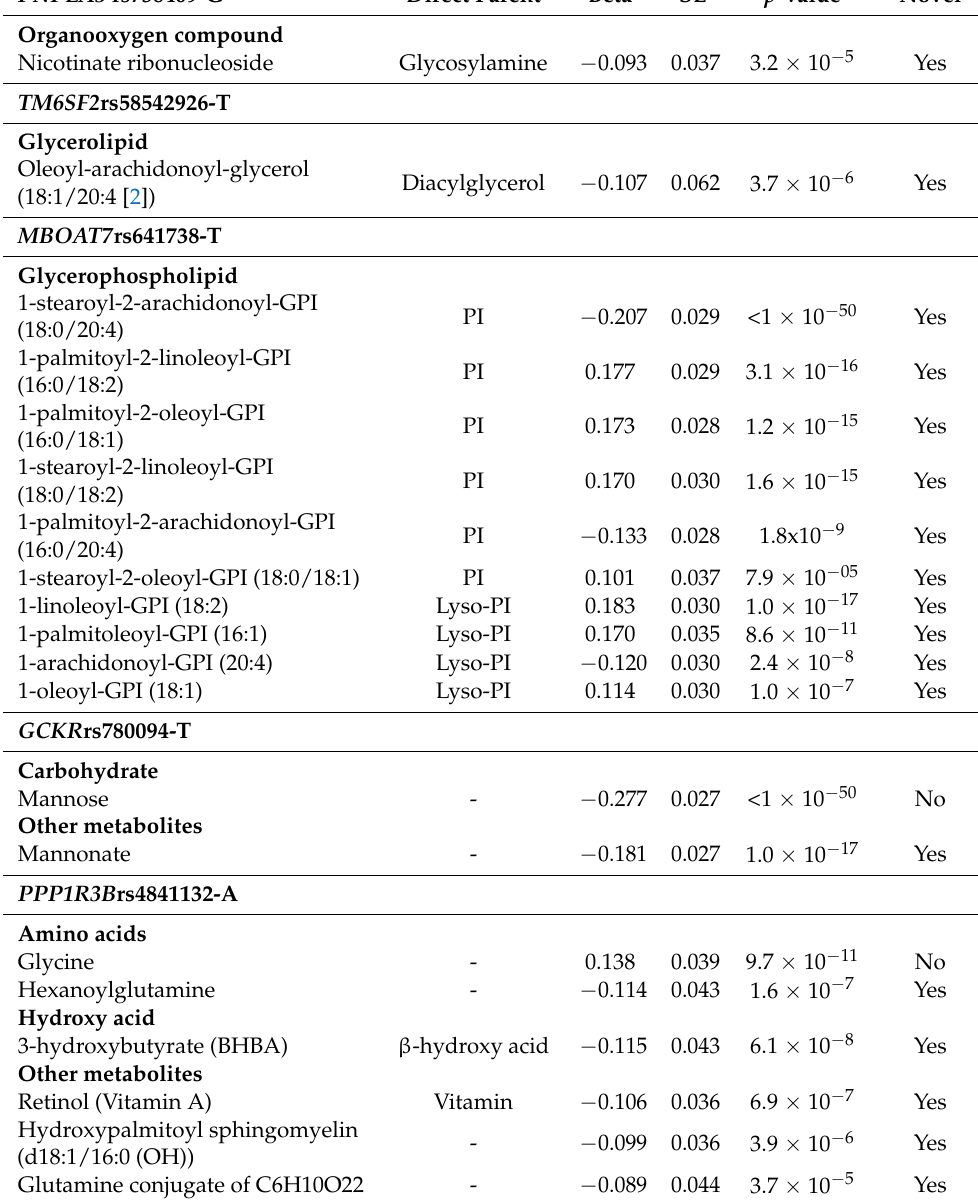
Table 2. Associations of PNPLA3 rs738409-G, TM6SF2 rs58542926-T, MBOAT7 rs641738-T, GCKR rs780094-T and PPP1R3B rs4841132-A with metabolites in men without